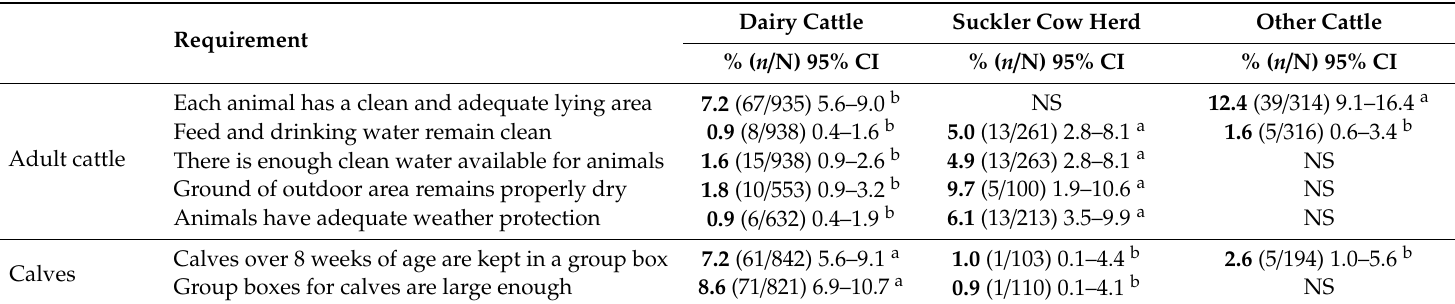
Table 6. Pairwise comparison of di ff erent cattle production types not complying with certain individual